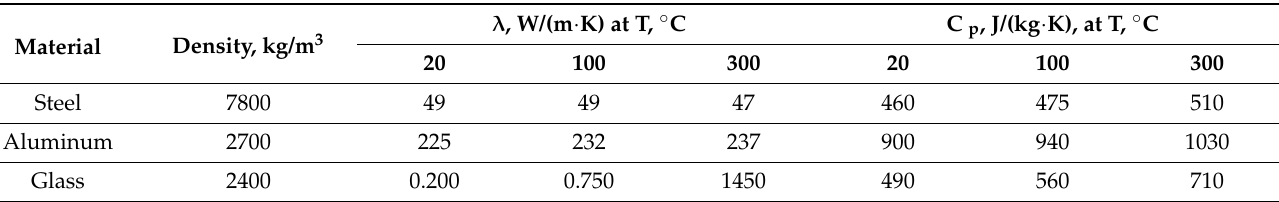
Table 2. Thermophysical characteristics of materials.